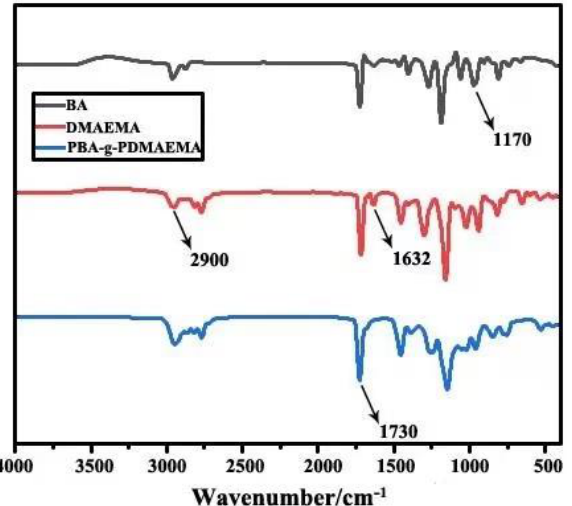
Figure 2. IR spectra of monomers and the copolymerization product.